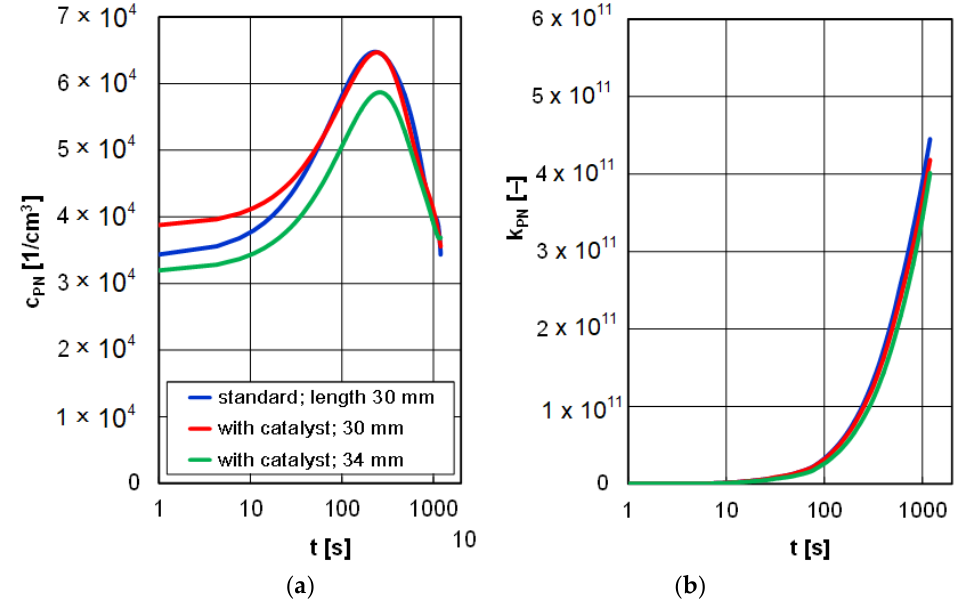
Figure 11 . Concentration ( a ) and number of particles ( b ) during the tests of a diesel engine depending on the type of glow plugs and the length of the catalyst-covered ones.